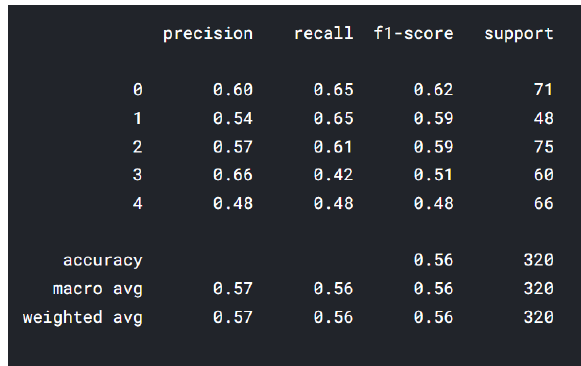
Figure 10. MobileNet classification report.